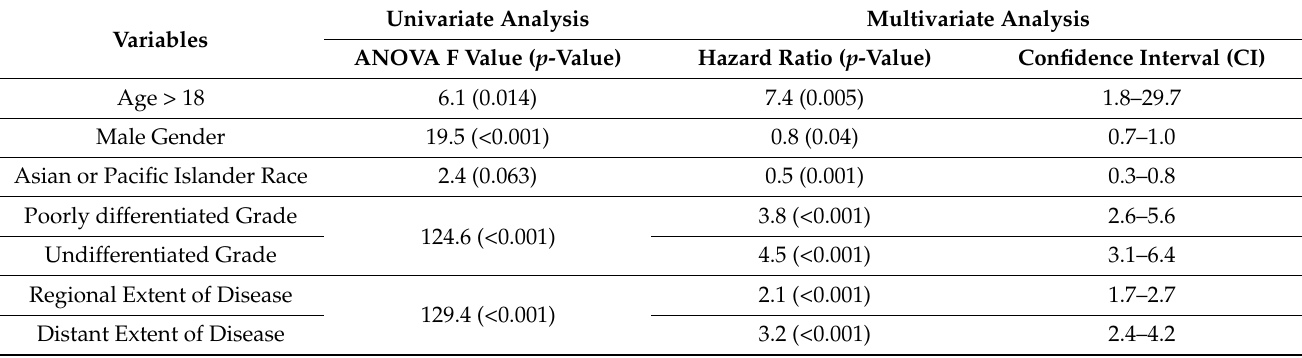
Table 4. Cox Regression analysis of age, sex, race, tumor grade, and tumor staging influencing mor- tality in 4507 patients with Mucoepidermoid Carcinoma (MEC) from the Surveillance Epidemiology and End Result (SEER) Database